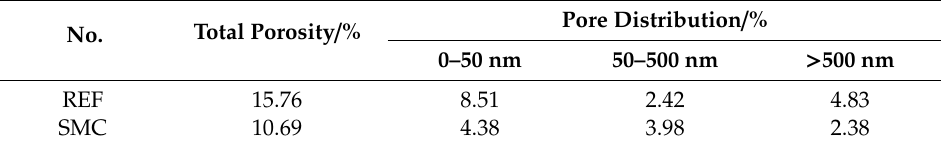
Table 5. Pore structure of